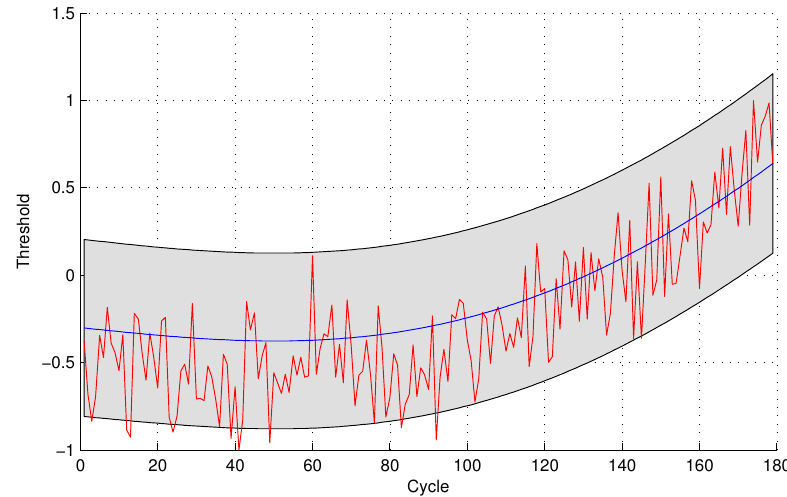
Figure 8. Anomaly detection for sensor data set 2 with GPR for the observing sensor selection.